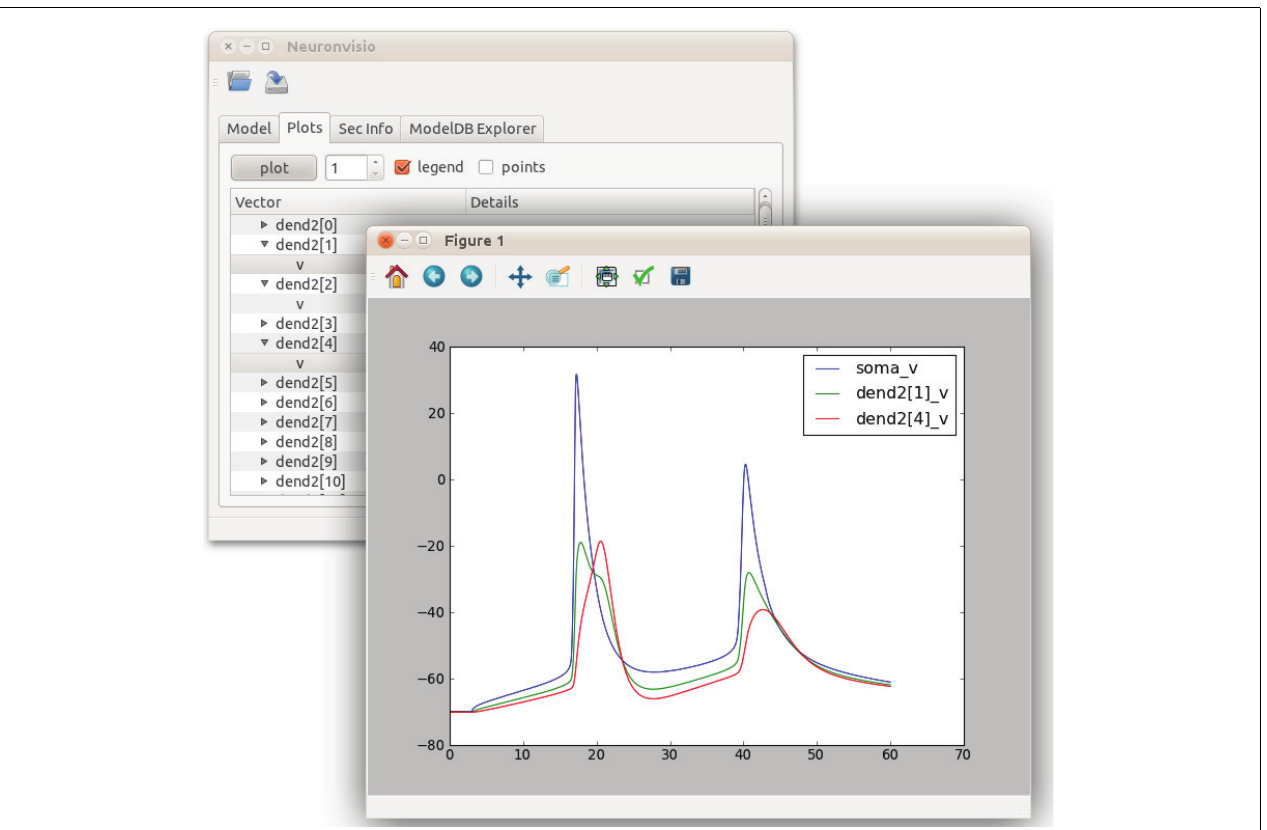
FIGURE 3 | Matplotlib integration in Neuronvisio. The graph shows the time courses of the depolarization of the pyramidal Neuron, using the model from Mainen et al. (1995).The voltage of soma is plotted in blue, while two dendrites are plotted in red and green.The voltage ( y -axis) is in millivolts and the time ( x -axis) is in